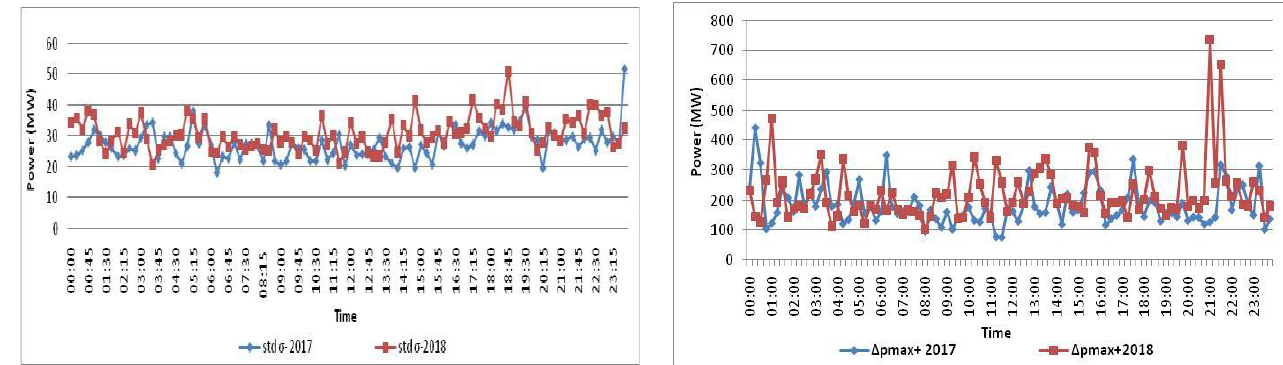
Figure 13. Comparison between standard deviation values of downward power ramps in 15 min interval at each observation time t for the years 2017 and 2018.